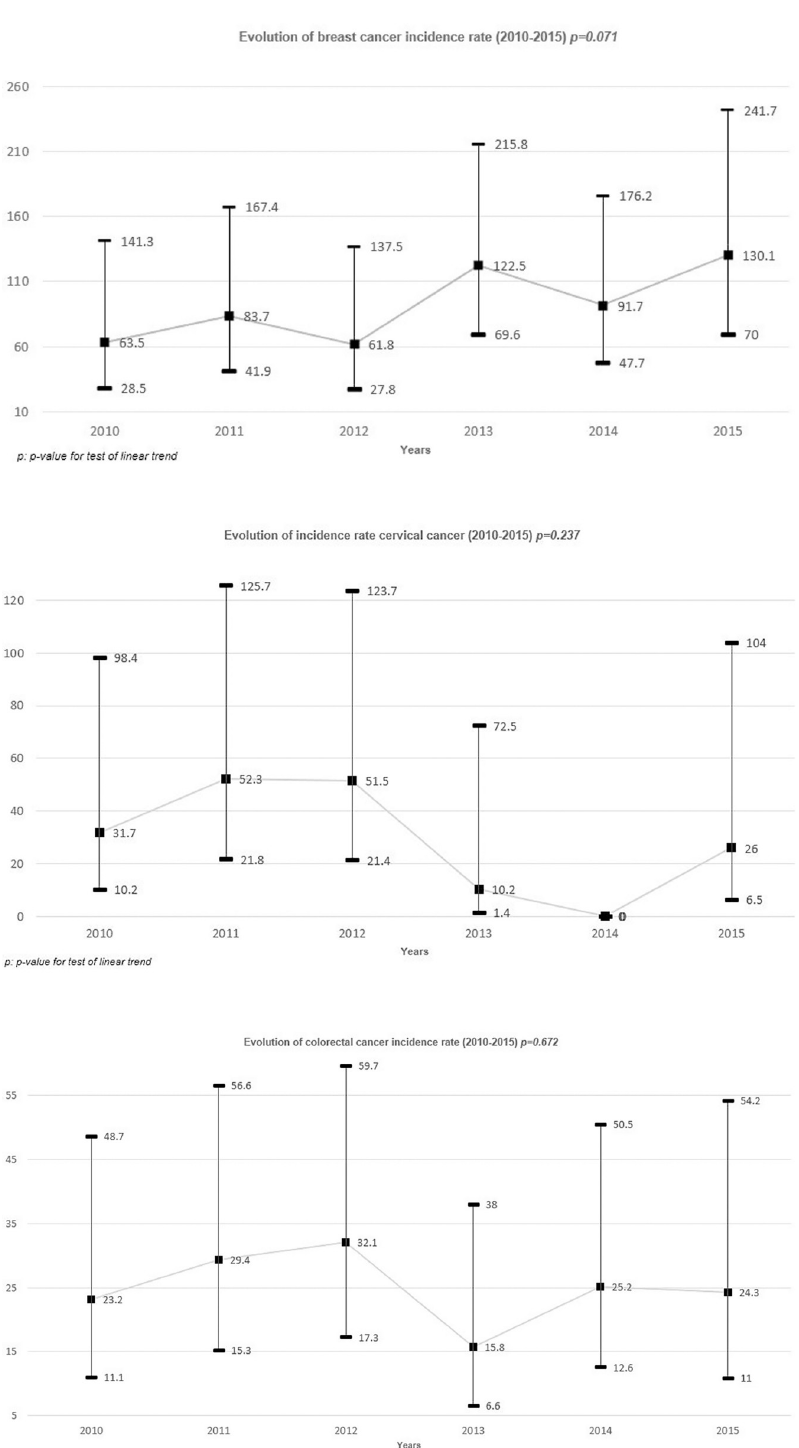
Fig 1. Evolution of cancer incidence rates by calendar year in the Dat’AIDS cohort between 01 January 2010 and 31 December 2015. A. Breast cancer. B. Cervical cancer. C. Colorectal cancer.